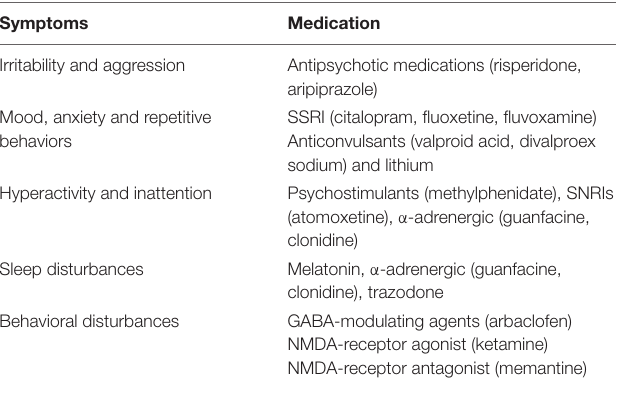
TABLE 1 | Medical management of ASD. Symptoms Irritability and